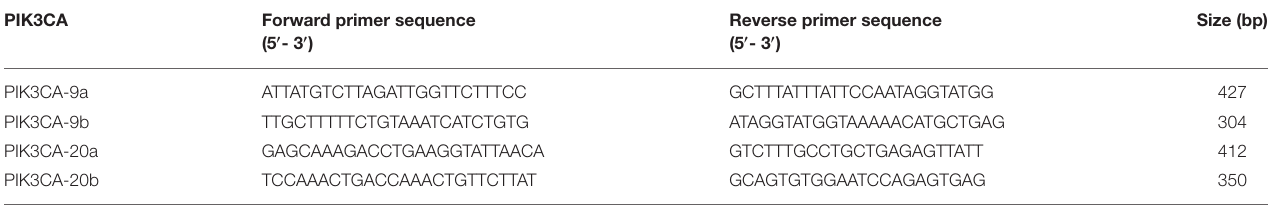
TABLE 2 | The primers used for Bisulfite-modified DNA amplification of CDKN2A. CDKN2A Forward primer sequence (5 ′ - 3 ′ )